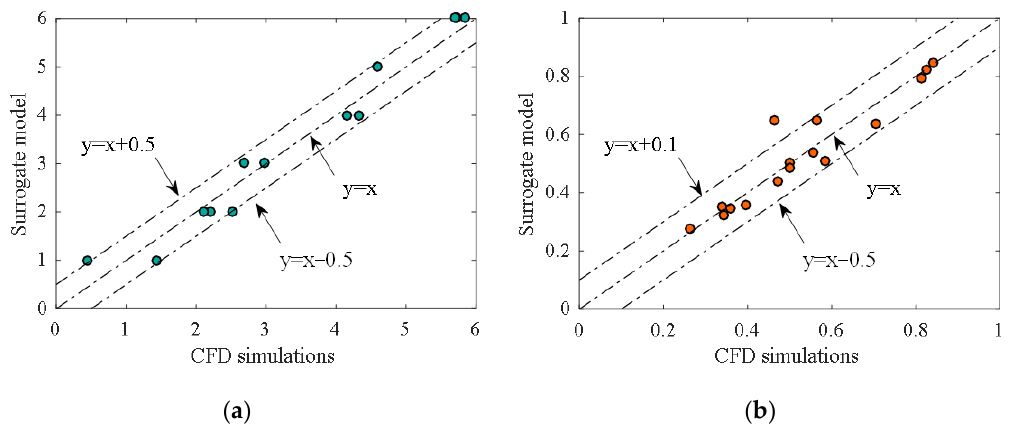
Figure 11. Direct validations of the KRG model. ( a ) Satellite droplet number prediction. ( b ) Droplet length prediction.